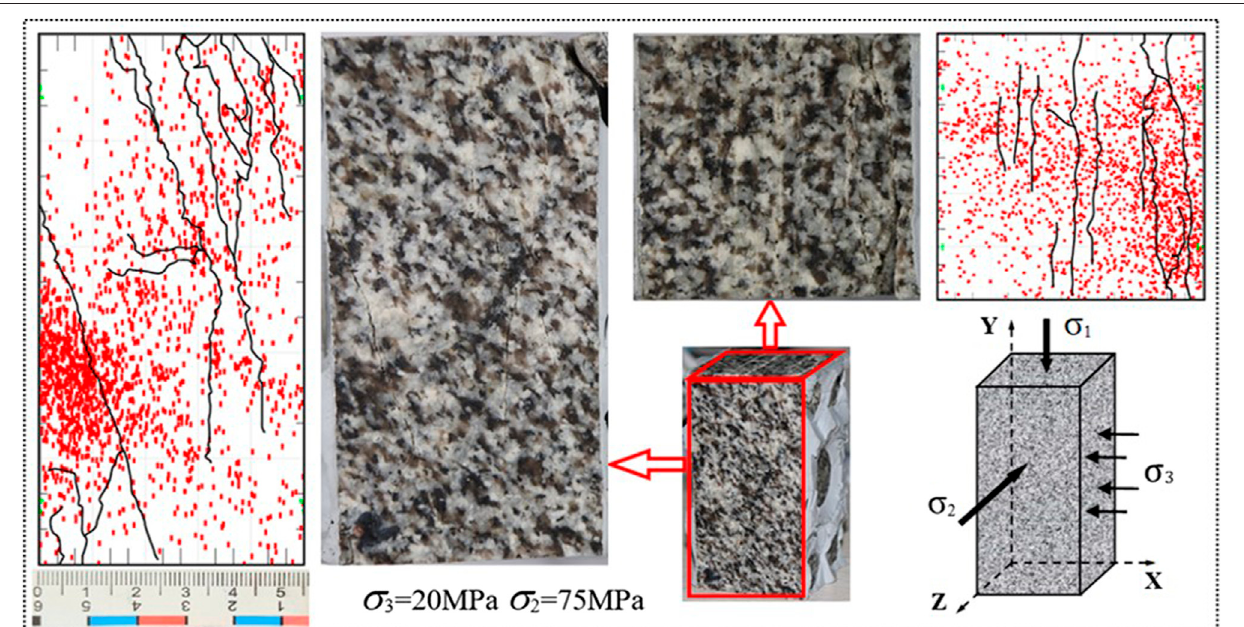
FIGURE 11 | Comparison diagram of fi nal failure mode, acoustic emission source location results, and crack sketch of tested granite under the true triaxial stress state.